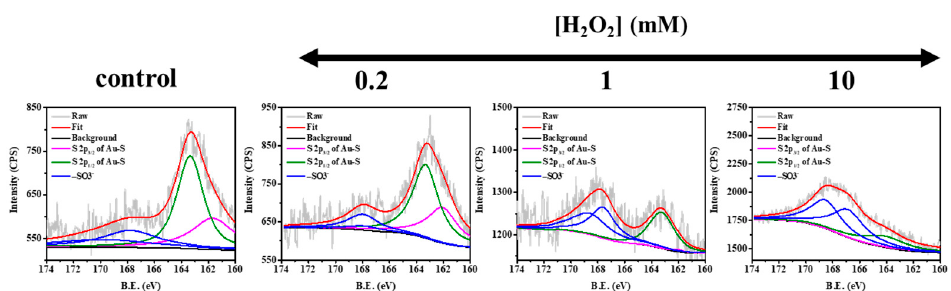
Figure 6. High-resolution XPS of S 2p spectra for GSH/BSA-AuNCs treated with 0–10 mM H 2 O 2 .